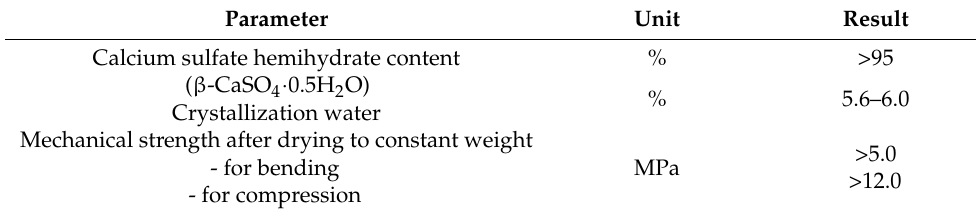
Table 1. Properties of gypsum used for research.